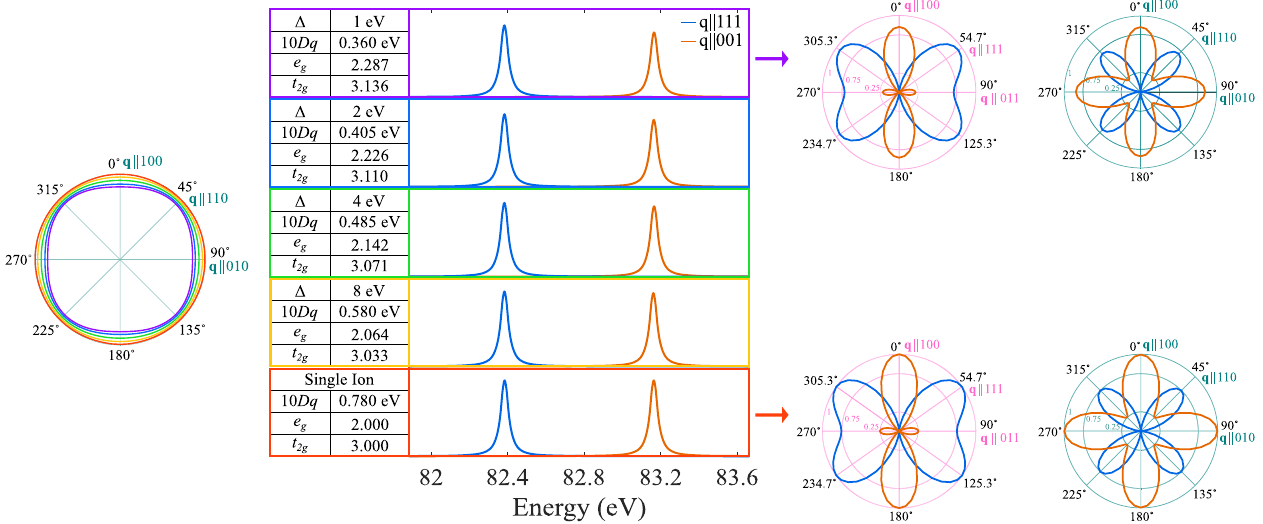
FIG. 6. Mn M 1 simulations using a MnS 6 cluster calculated for various degrees of covalency. Left: Polar plot of the integrated intensity of the Mn M 1 in the ½ 100 (cid:2) → ½ 110 (cid:2) → ½ 010 (cid:2) plane: from ionic (most outer circle) to strongly covalent (most inner distorted circle, Δ ¼ 1 eV) case. Middle: Mn M q k [100] (orange) and q k [111] (blue) directions: from ionic (bottom curves) to 1 spectra along the strongly covalent (top curve, Δ ¼ 1 eV). The Δ and corresponding ionic 10 Dq values are indicated, together with the resulting e t 2 occupation numbers. The energy splitting between the q k [100] (orange) and q k [111] (blue) peaks is fixed at 0.78 eV. Right: The g directional dependence of the high (orange) and low energy peak (blue) of Mn M 1 spectra, for the ionic (bottom) and strongly covalent (top, Δ ¼ 1 eV)